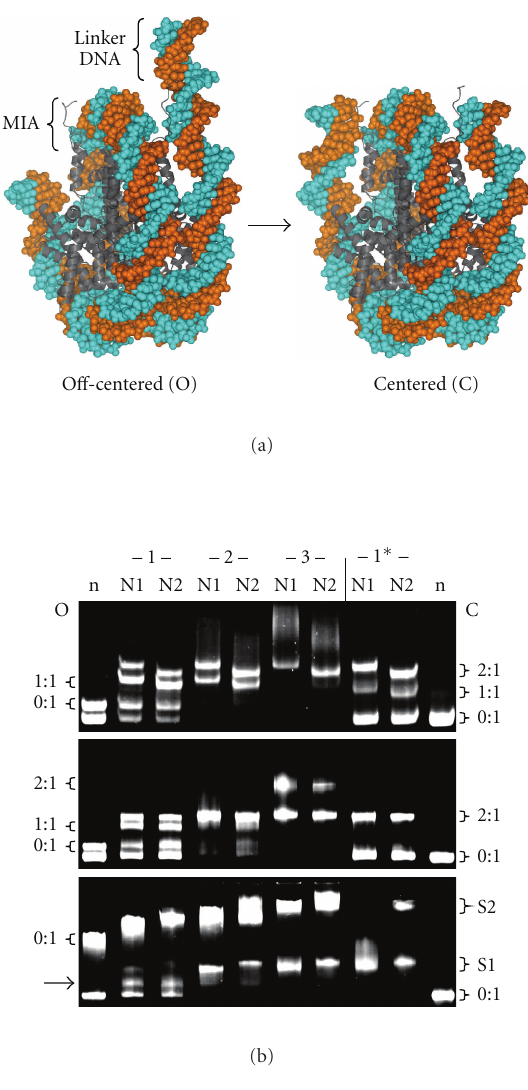
Figure 5: O ff -centered NCP undergoes a transition in the presence of divalent metal and associates with HMGNs to form an S2- like state. (a) Crystal structure-based [19] models for o ff -centered and centered NCP. DNA strands are colored orange and cyan and histone proteins are grey. O ff -centered NCP is missing an interaction between one DNA terminus and the N-terminal tail of H3 (MIA). (b) EMSAs of HMGN binding to centered (C; right) versus o ff -centered (O; left) NCP146b. Gel labels indicate HMGN identity (N1t, HMGN1t; N1, HMGN1; N2, HMGN2; n, NCP alone), and numbers designate HMGN:nucleosome molar stoichiometry. O ff -centered samples (left 7 lanes) also contain a fraction of faster migrating centered NCP. Gels were run under three di ff erent bu ff er conditions: low ionic strength (top), near physiological ionic strength (middle), and near physiological ionic strength with 1 mM Mg 2+ (bottom). HMGN:nucleosome molar stoichiometry ( ∗ ) for centered samples (right 3 lanes) is 1:1 (top, middle) or 3:1 (bottom). Assignments of 1: 1 and 2:1 HMGN: o ff -centered NCP species are inferred by comparison with those for centered NCP (see text for details). The additional band observed at low HMGN stoichiometry with Mg 2+ (arrow) may coincide with a minor fraction of o ff -centered NCP in a compact state associated with one molecule of